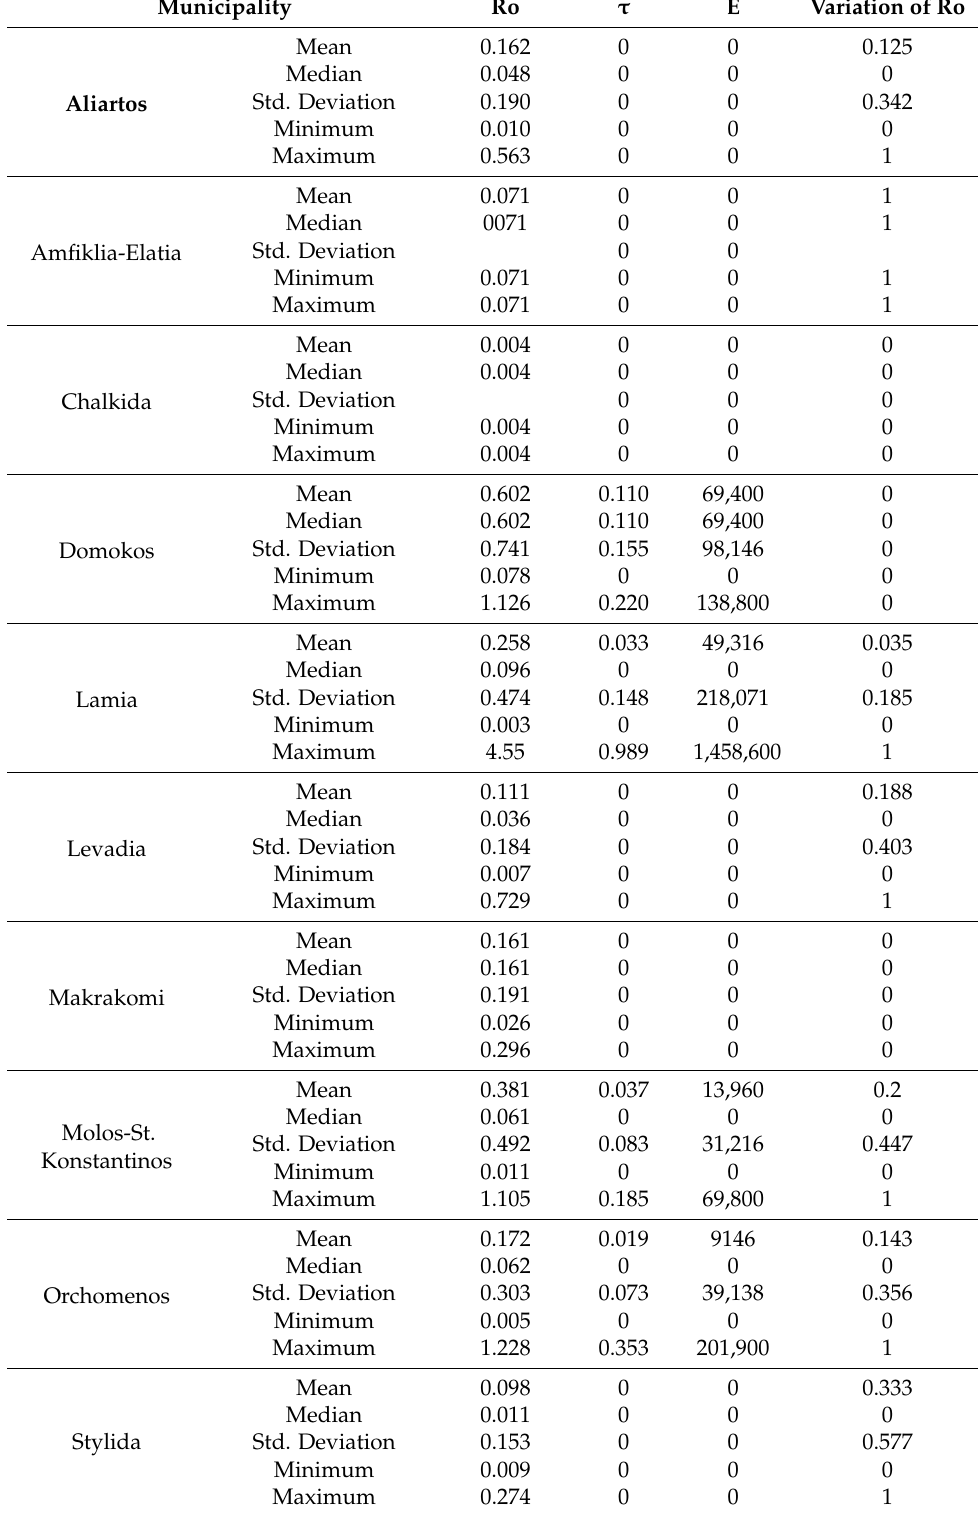
Table A4. Descriptive statistics of the estimated risk measures, broken down by